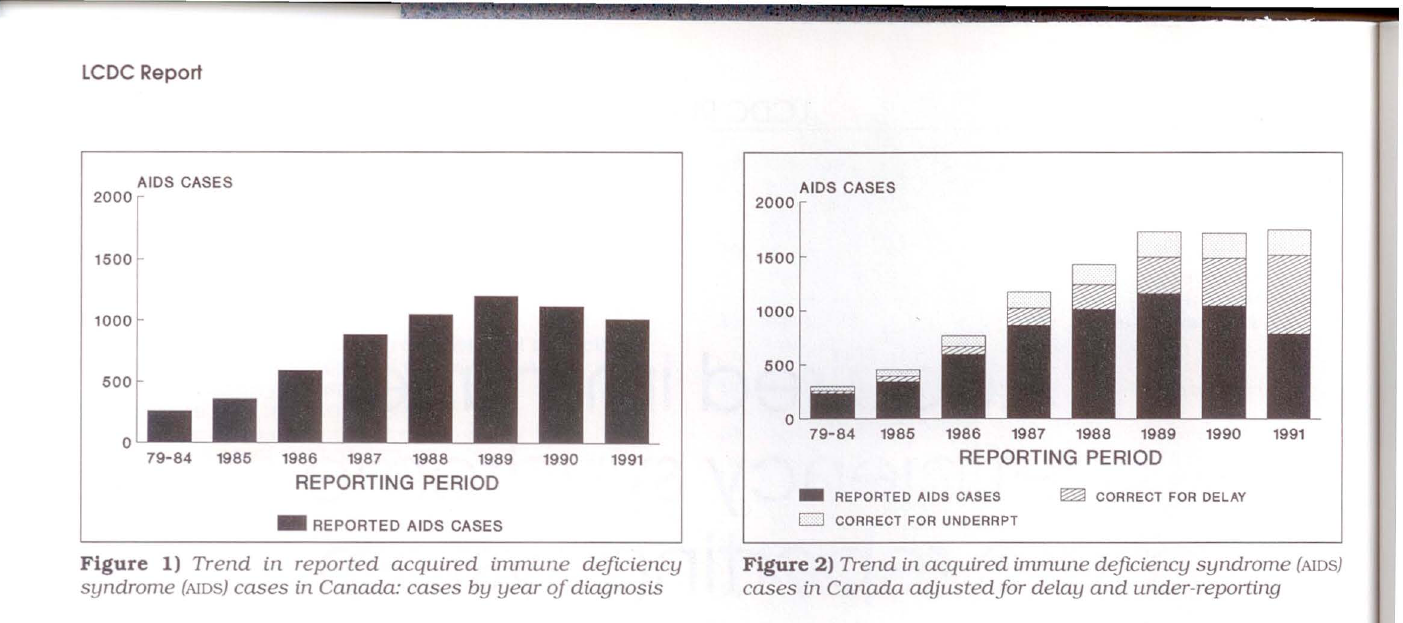
Figure 2) Trend in acquired immune deficiency syndrome (AJosJ cases in Canada adjusted for delay and under-reporting